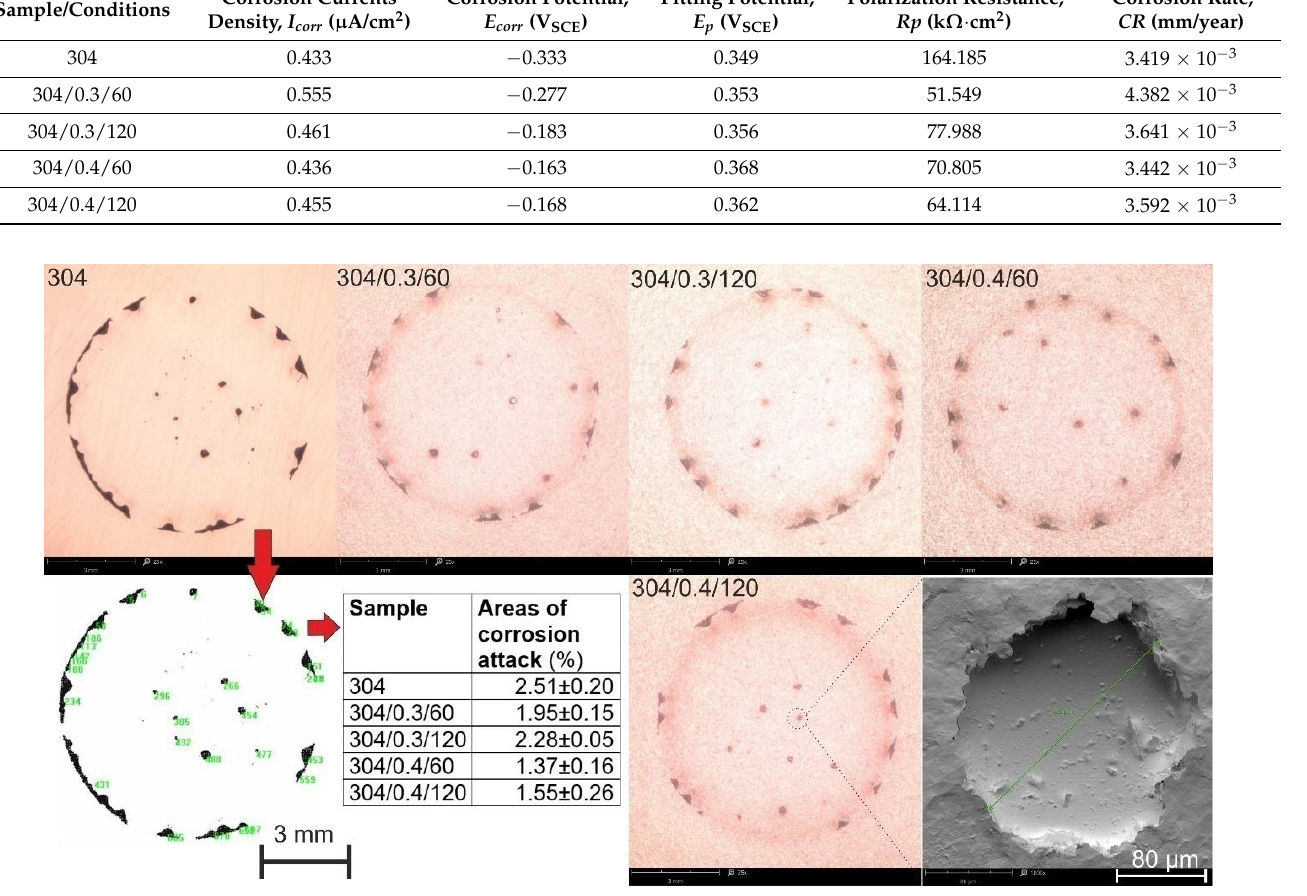
Table 4. Results of electrochemical corrosion reported for unpeened and shot peened AISI 304 steel. Sample/Conditions